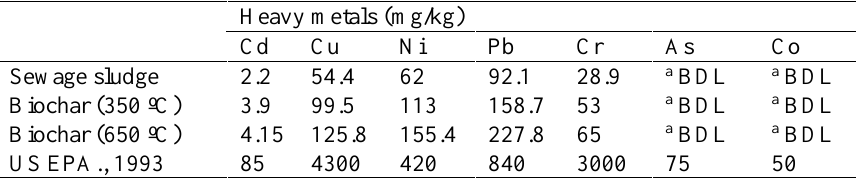
Table 4. Heavy metal analysis of the sewage sludge and biochars Heavy metals